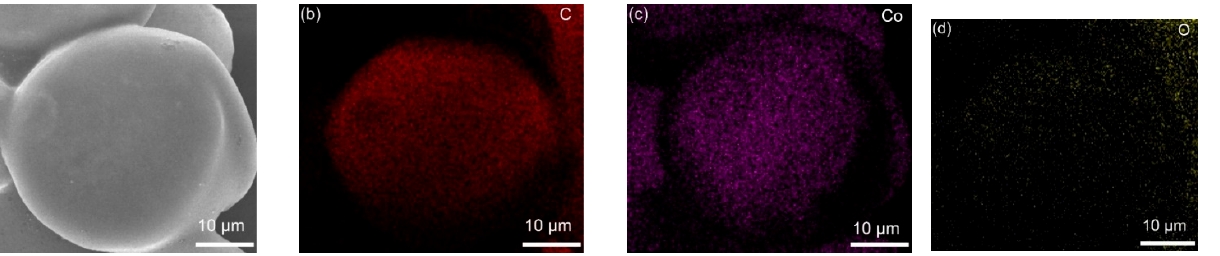
Figure 5. ( a ) SEM and ( b – d ) mapping images of the Co 3 O 4 -infilled microcapsules. ( e ) Related EDS spectrum.